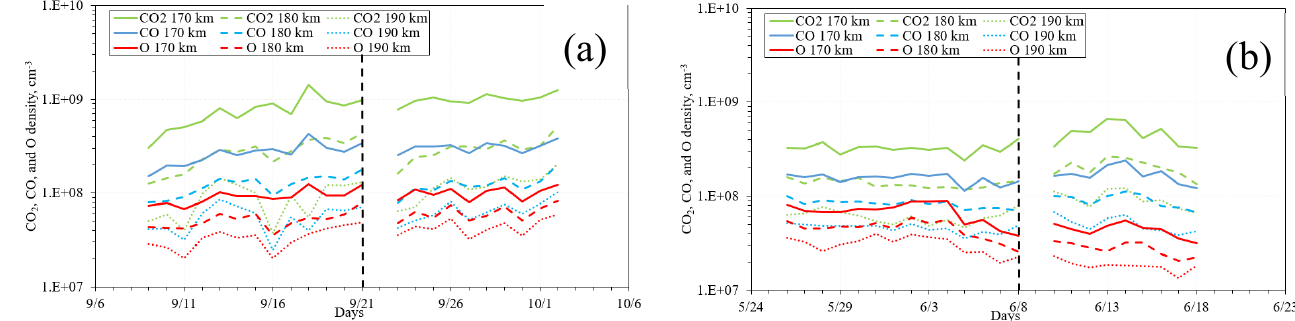
Figure 5. Distribution of (O 2+ , CO 2+ , and O + ) ion species density normalized to their own pre-storm den- sities as a function of altitude ( a1 – c1 ) 9 September–2 October 2016 (RDS 2016); ( a2 – c2 ) 27 May to 17 June 2018 (GDS 2018). The vertical black line indicates the storm onset. The blank regions represent missing data.